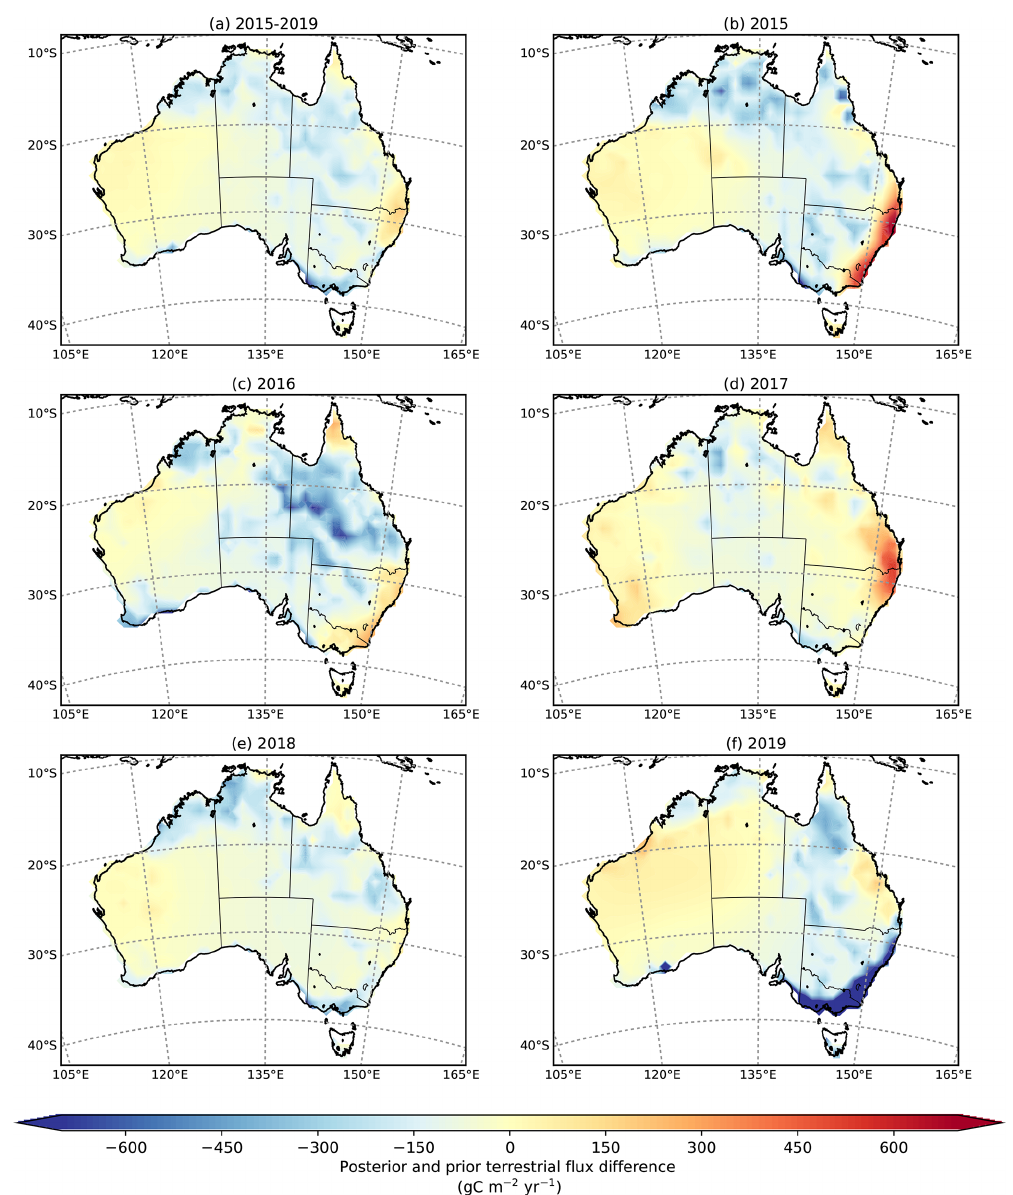
Figure 5. Annual spatial pattern of the differences between posterior and prior carbon fluxes for 2015–2019 (gCm − 2 yr − 1